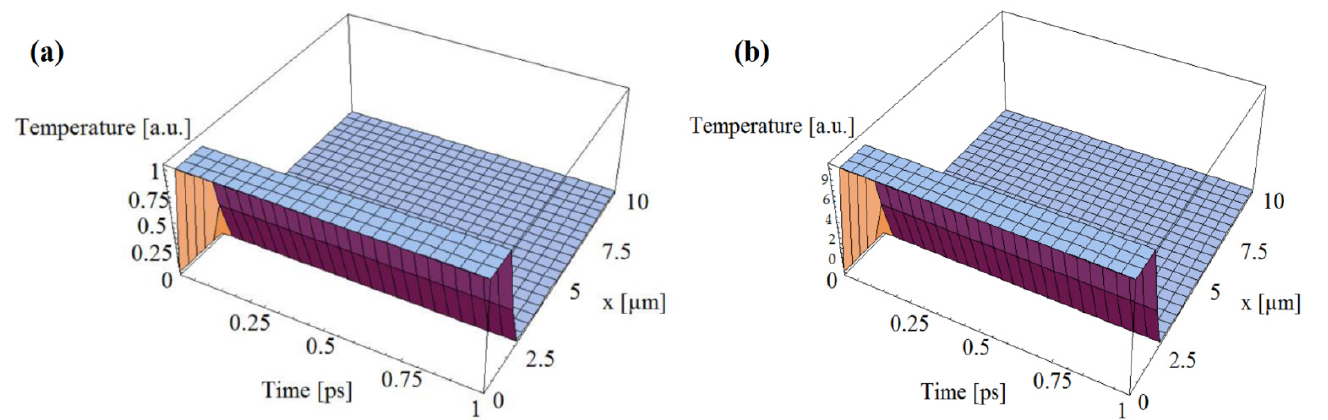
Figure 7. ( a ) Spatial–temporal distribution of the electrons’ thermal field generated by one laser pulse on an Au surface, when t = 100 fs and τ = 1 ps versus time (1 ps), and ( b ) influence of g/K value on temperature intensity at g = 1.05 × 10 16 W/m 3 K, K = 315 W/mK, and laser pulse duration of 100 fs [19]; published under MDPI's open access license.